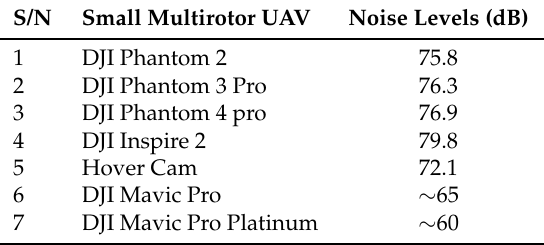
Table 1. Noise levels generated by some small multirotor unmanned aerial vehicles (UAVs)